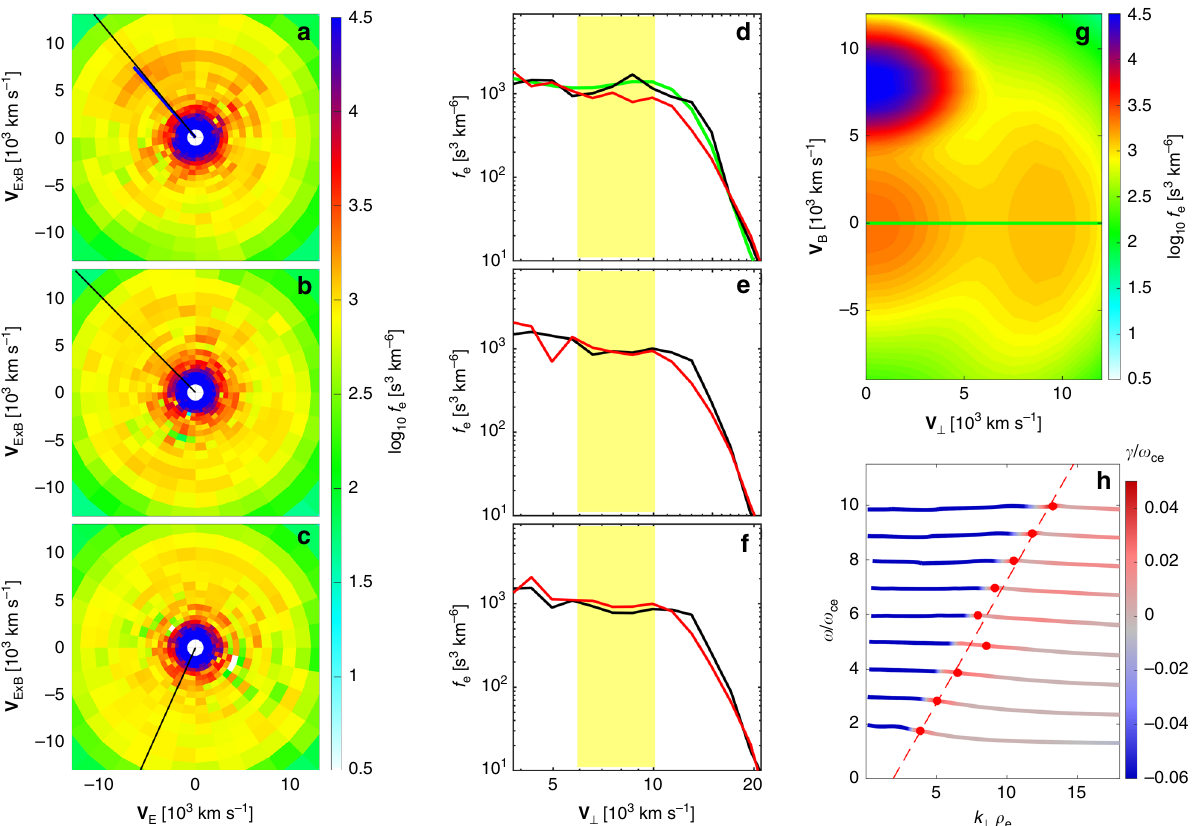
Fig. 6 Generation mechanism of the EBWs. a – c Electron distributions at times indicated by the vertical green lines in Fig. 5b. The black lines in each panel denote the ^ k direction. The blue line in ( a ) denotes the E direction. d – f 1D electron distribution pro fi les along ^ k and (cid:1) ^ k from ( a ) to ( c ), respectively. The max yellow shading denotes the domain of electron trapping by the EBWs potential. g Electron model distribution for the observed distribution in ( a ). The 1D pro fi le along V ? (green line) is presented in ( d ). h Dispersion relation of the unstable electron Bernstein mode. The red dots denote the maximum growth rates ( fi tted by the red-dashed